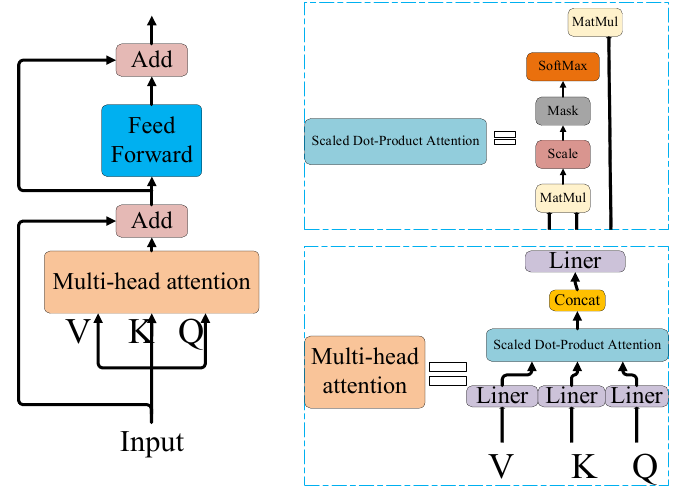
Figure 4. The module structure of the transformer self-attention mechanism.